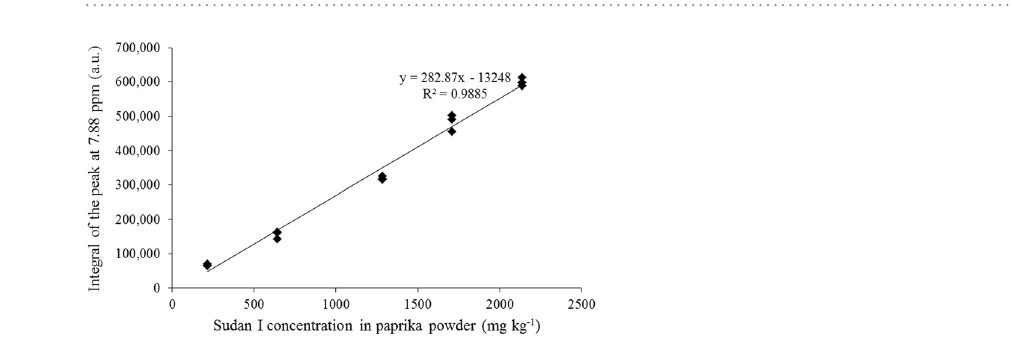
Figure 5. 1 H HR MAS SSNMR spectra of paprika powder spiked with Sudan I at various concentrations (0, 225, 675, 1350, 1800, and 2250 mg kg − 1 ).